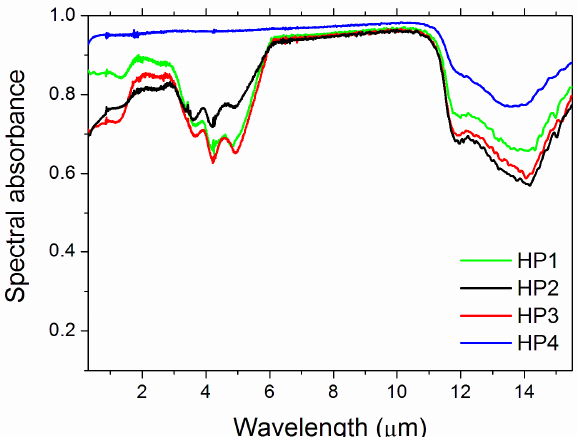
Figure 4. Room-temperature spectral absorbance.